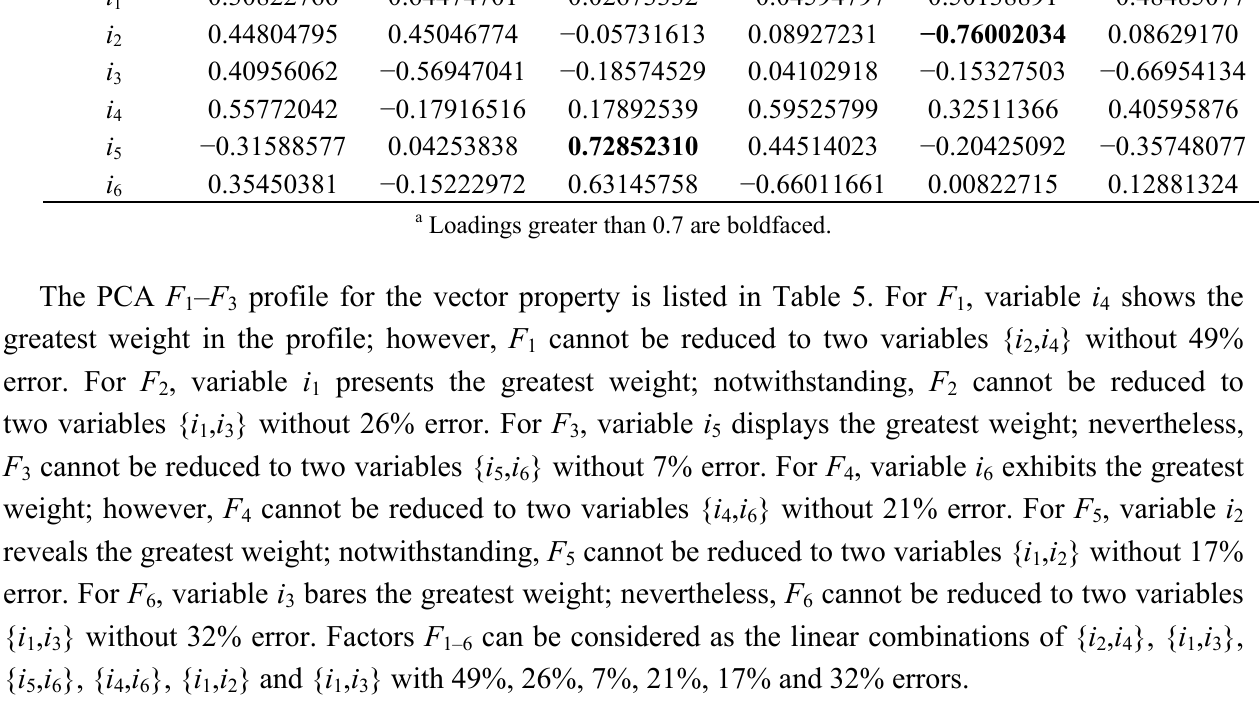
Table 4. Principal component analysis loadings for the vector property of pesticides.